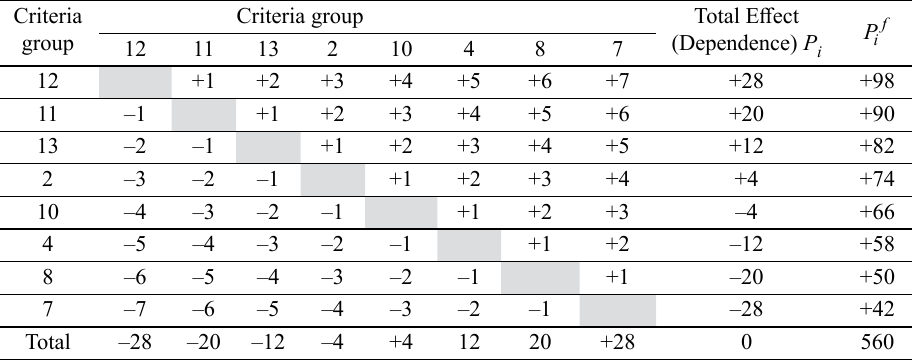
Table 8. The results obtained in calculating the total effect